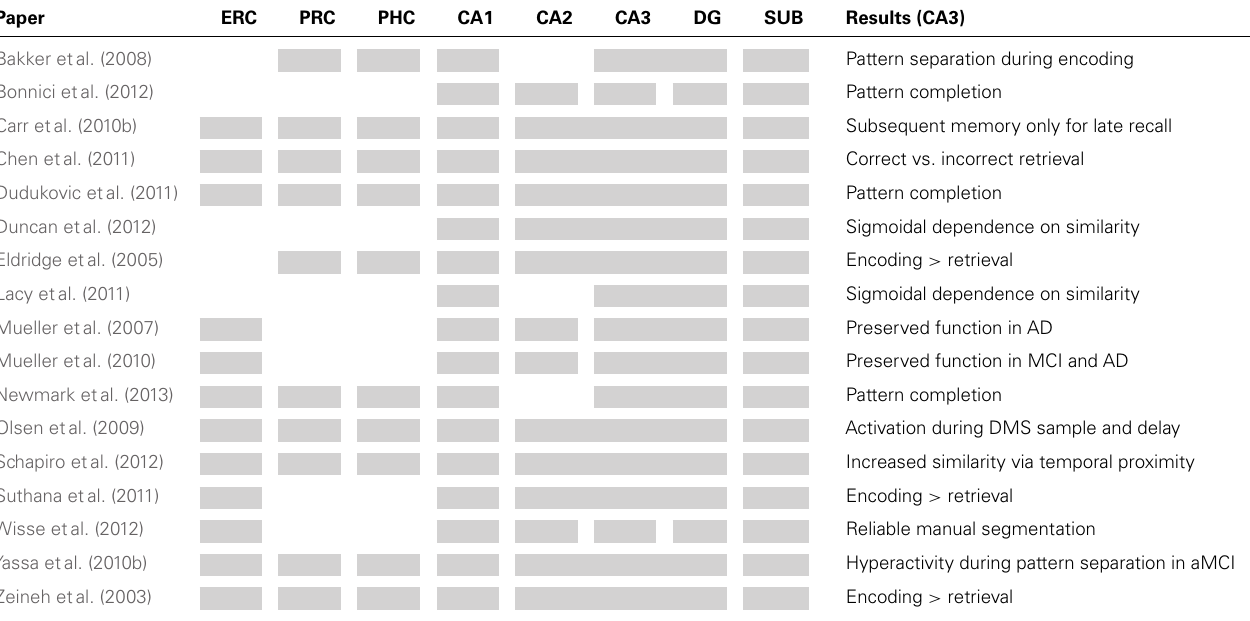
Table 1 | Overview of selected publications which have investigated the function of CA3 and other MTL and hippocampal subfields in